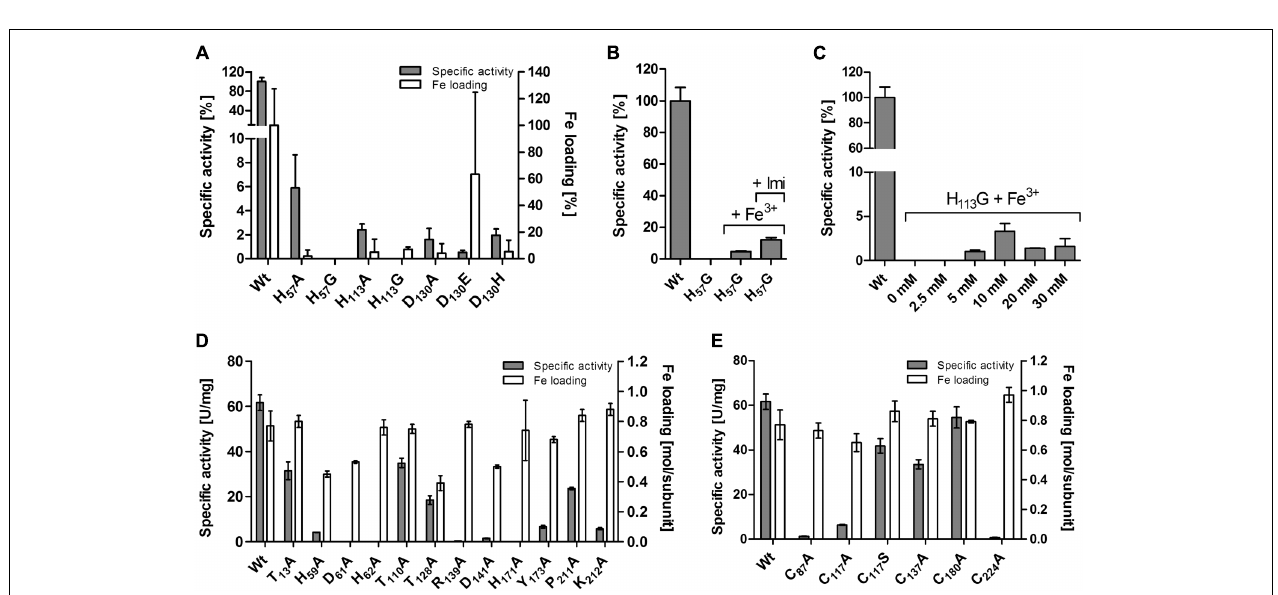
FIGURE 6 | Effects of site-directed mutagenesis in the Ac PDO gene on the enzyme activity and iron content of the corresponding protein variants. (A) Variants of the iron ligands. (B) Reconstitution of the H 57 G variant with Fe and imidazole in the enzyme assay buffer. (C) Reconstitution of the H 113 G variant with Fe and increasing concentrations of imidazole. (D) Mutagenesis of substrate-binding site and hydrogen bond network. (E) Cysteine variants. Error bars represent the standard deviation from triplicate measurements.